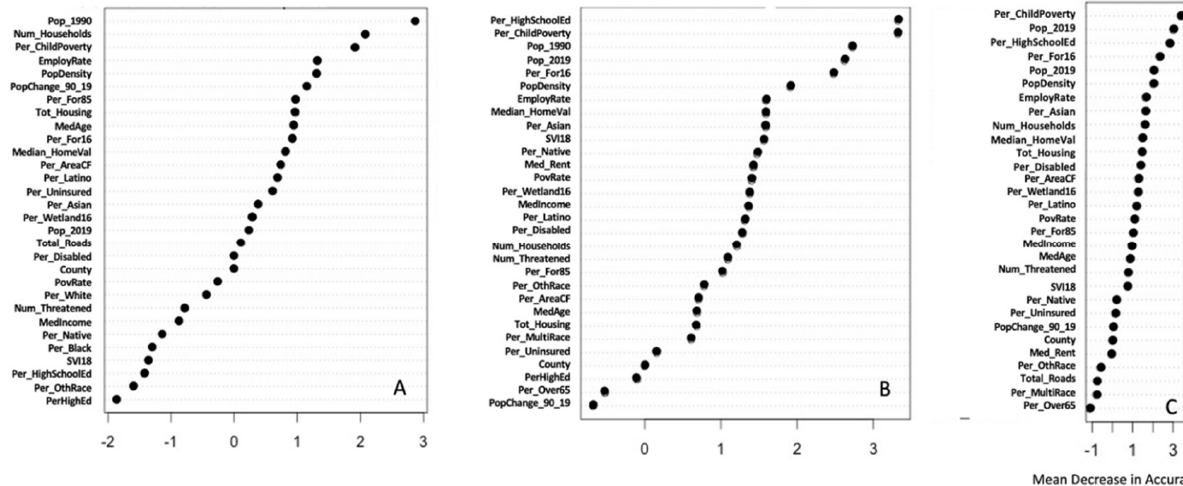
Figure 5. Variable importance by class. ( A ) Represents seven Michigan counties with biomass plants; ( B ) represents Michigan counties without biomass facilities but adjacent to ones with such facilities; ( C ) cumulative model highlighting overall variable importance through mean decrease in accuracy.